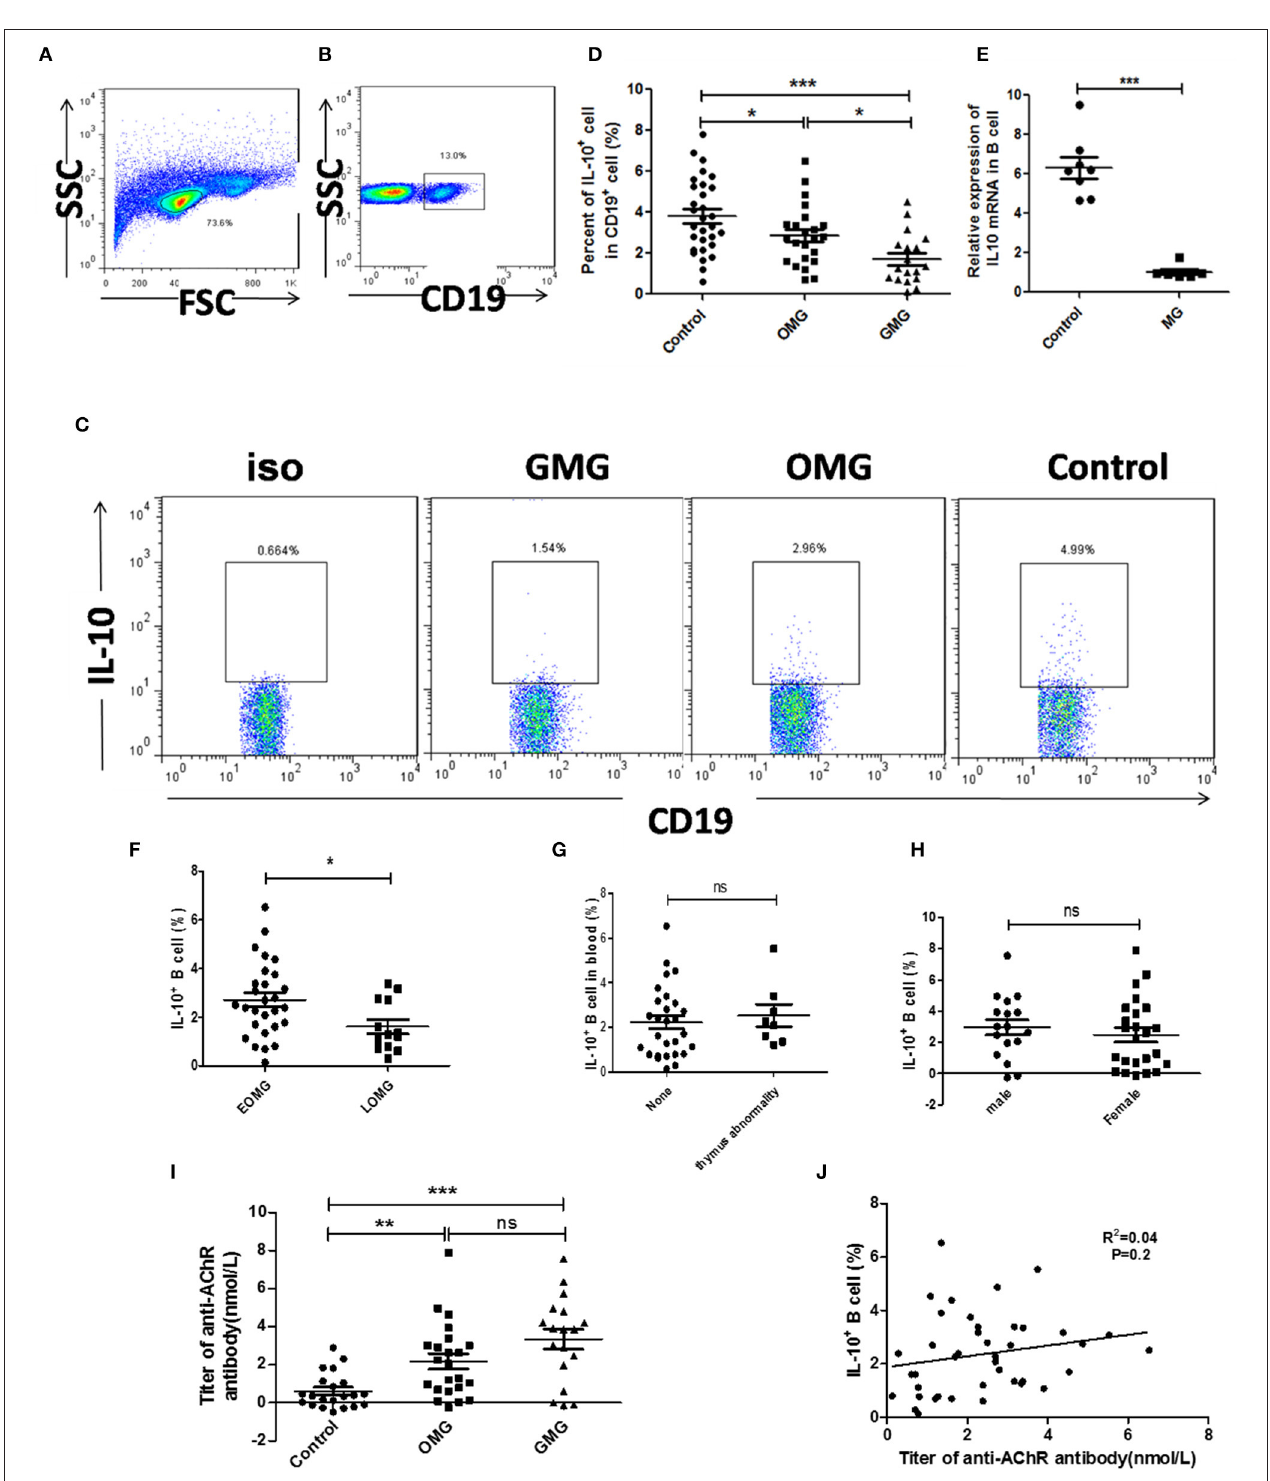
FIGURE 1 | The proportion of CD19 + IL-10 + cells in peripheral blood cells of MG patients and controls. (A) Lymphocytes were gated according to forward scatter and side scatter by FCM. (B) B cells were gated according to CD19 + in lymphocytes. (D) Scatter plots show the mean percentages of CD19 + IL-10 + cells in the peripheral blood of 23 OMG patients, 18 GMG patients, and 30 healthy individuals. (E) Expression of IL-10 mRNA by real-time quantitative analysis in the peripheral blood of 8MG patients and 8 healthy individuals. Six of 8MG patients were ocular myasthenia gravis. (C) Representative flow cytometry plot of CD19 + IL-10 +